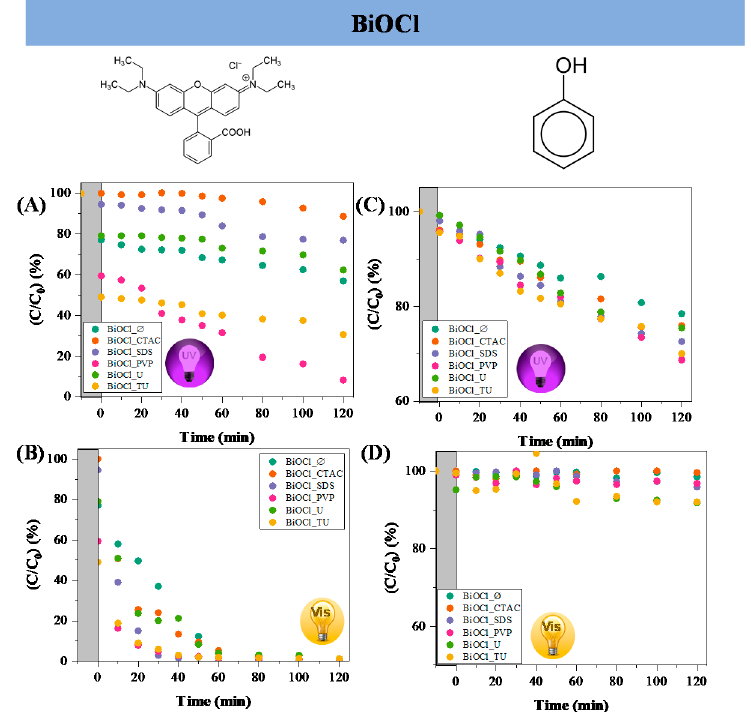
Figure 4. The photocatalytic degradation of RhB using BiOCl materials synthesized in the presence of different additives under UV-A ( A ) and visible light ( B ) irradiation; phenol photodegradation under UV-A ( C ) and visible light ( D ) with the same photocatalysts.